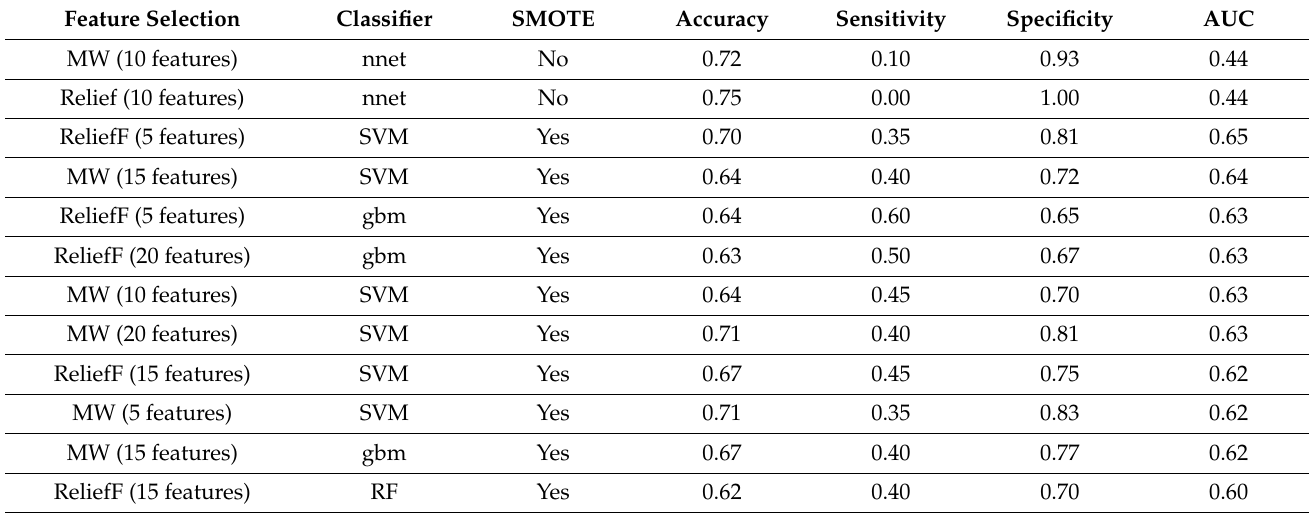
Table 5. KRAS mutation prediction results on Test dataset, base